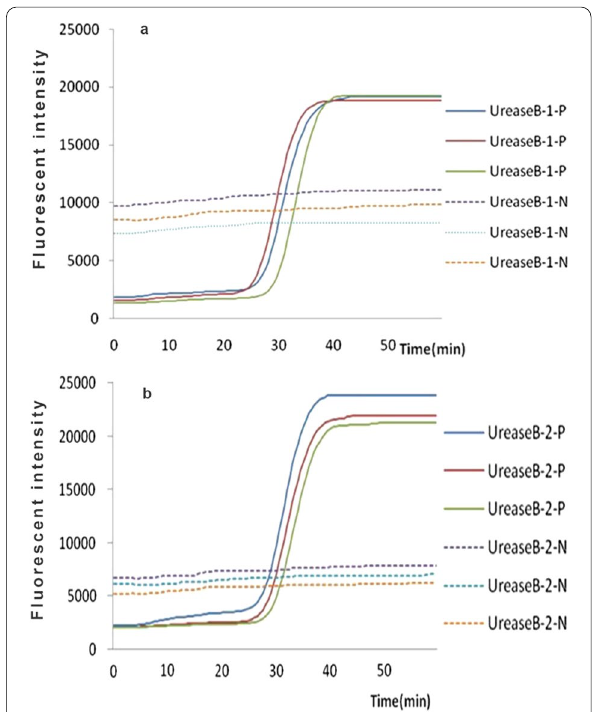
Fig. 1 The primers of real‑time fluorescence LAMP screening test